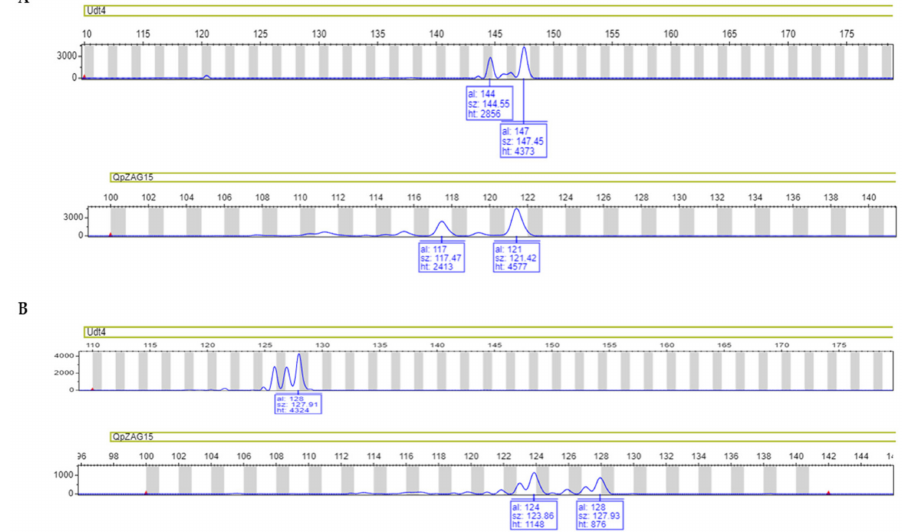
Figure 2. Electropherogram of Udt4 (chloroplast) and QrZAG15 (nuclear) SSR locus in Q. ilex ( A ) and Q. suber ( B